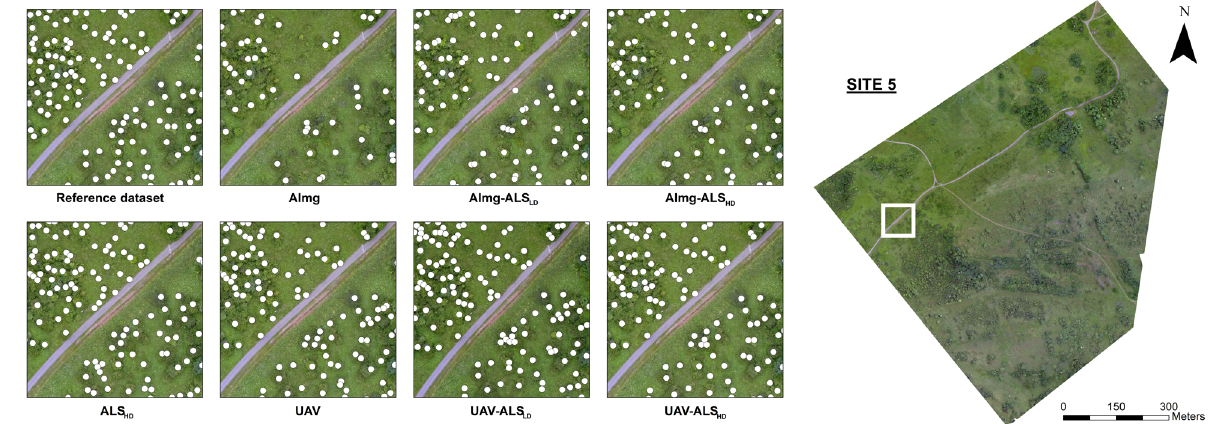
Figure 4. Examples of the individual woody plant detections for seven created nDSMs and the reference orthomosaic created by visual interpretation (top left corner) on the sample of Site 5. White dots represent individual detected shrubs and trees. White frame represents a subset of the study Site 5.